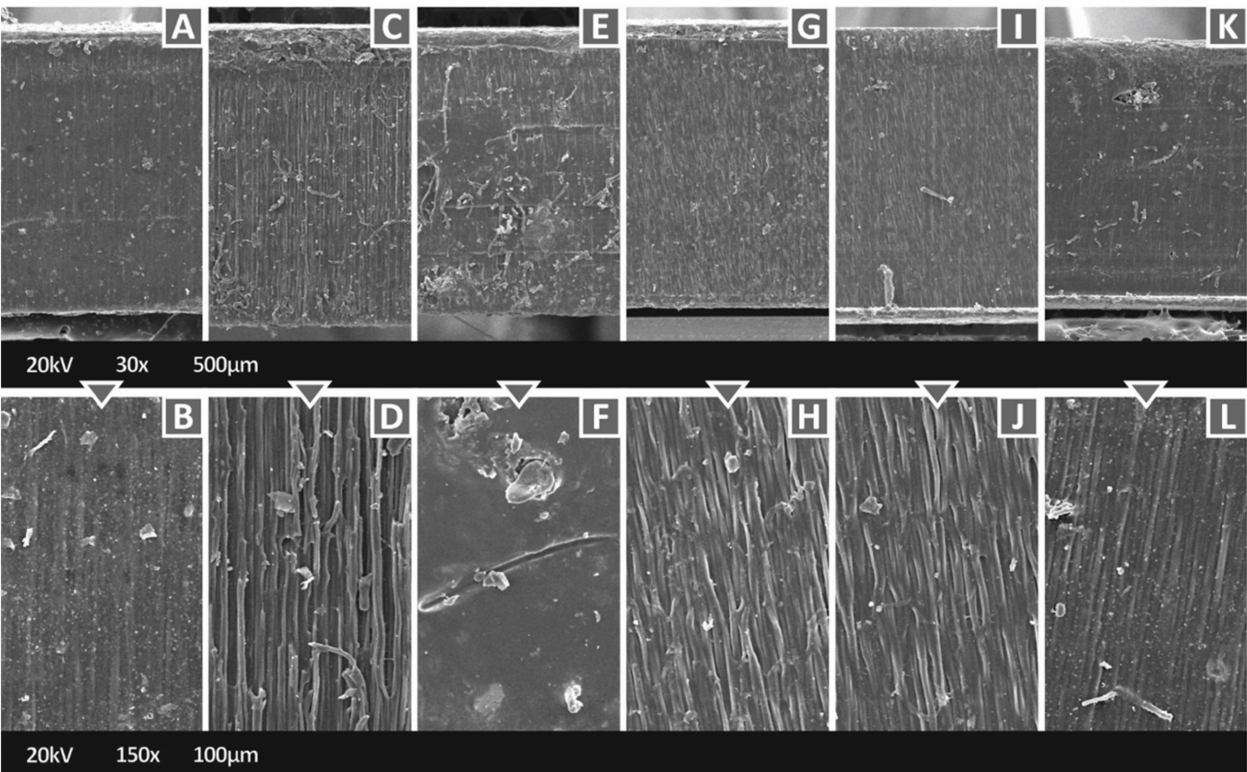
Figure 6. SEM images of the side surfaces of the specimens: ( A ) Biomed Clear 1 wt.% Antibacterial Powder, 30 × , ( B ) Biomed Clear 1 wt.% Antibacterial Powder 150 × side, ( C ) Biomed Clear 1 wt.% CNF and 1 wt.% Cu 30 × , ( D ) Biomed Clear 1 wt.% CNF and 1 wt.% Cu 150 × , ( E ) Biomed Clear 1